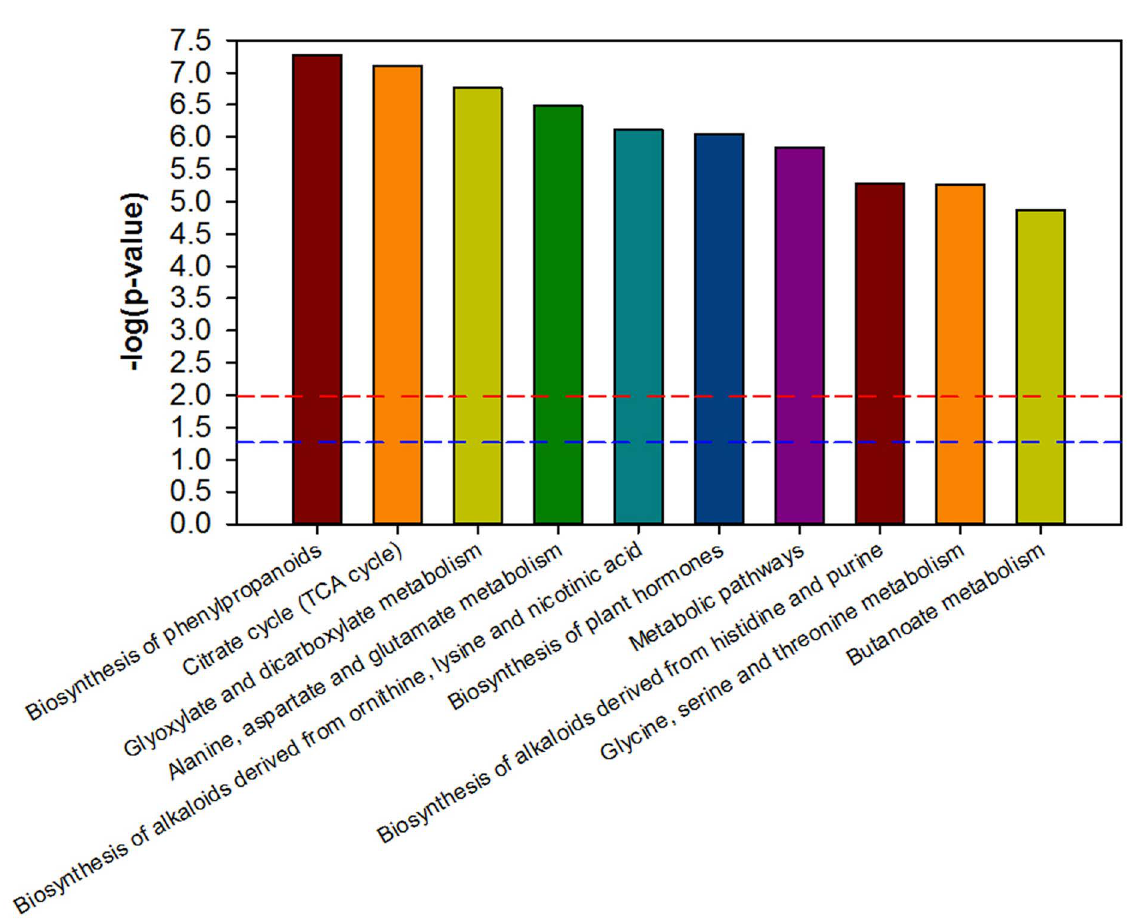
Figure 3. Main KEGG pathways related to differential metabolites of PSP storage roots between the 60% shading and nonshaded treatments. Kyoto encyclopedia of genes and genomes, KEGG; purple-fleshed sweet potato,